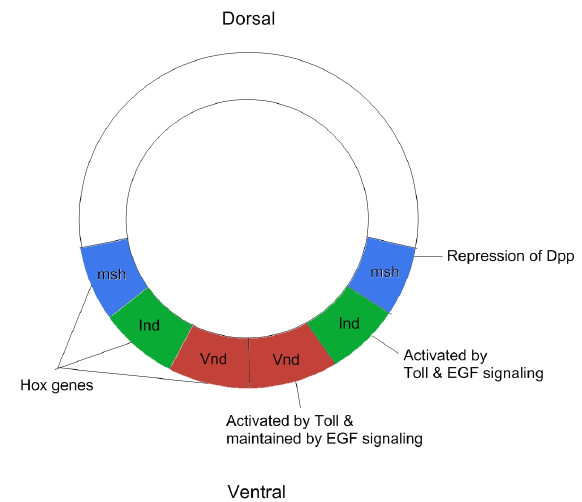
Figure 2. The signaling pathways involved in dorsal-ventral patterning of the neuroectoderm as shown by a transverse section of an early stage embryo (Stage 5 just before gastrulation starts).